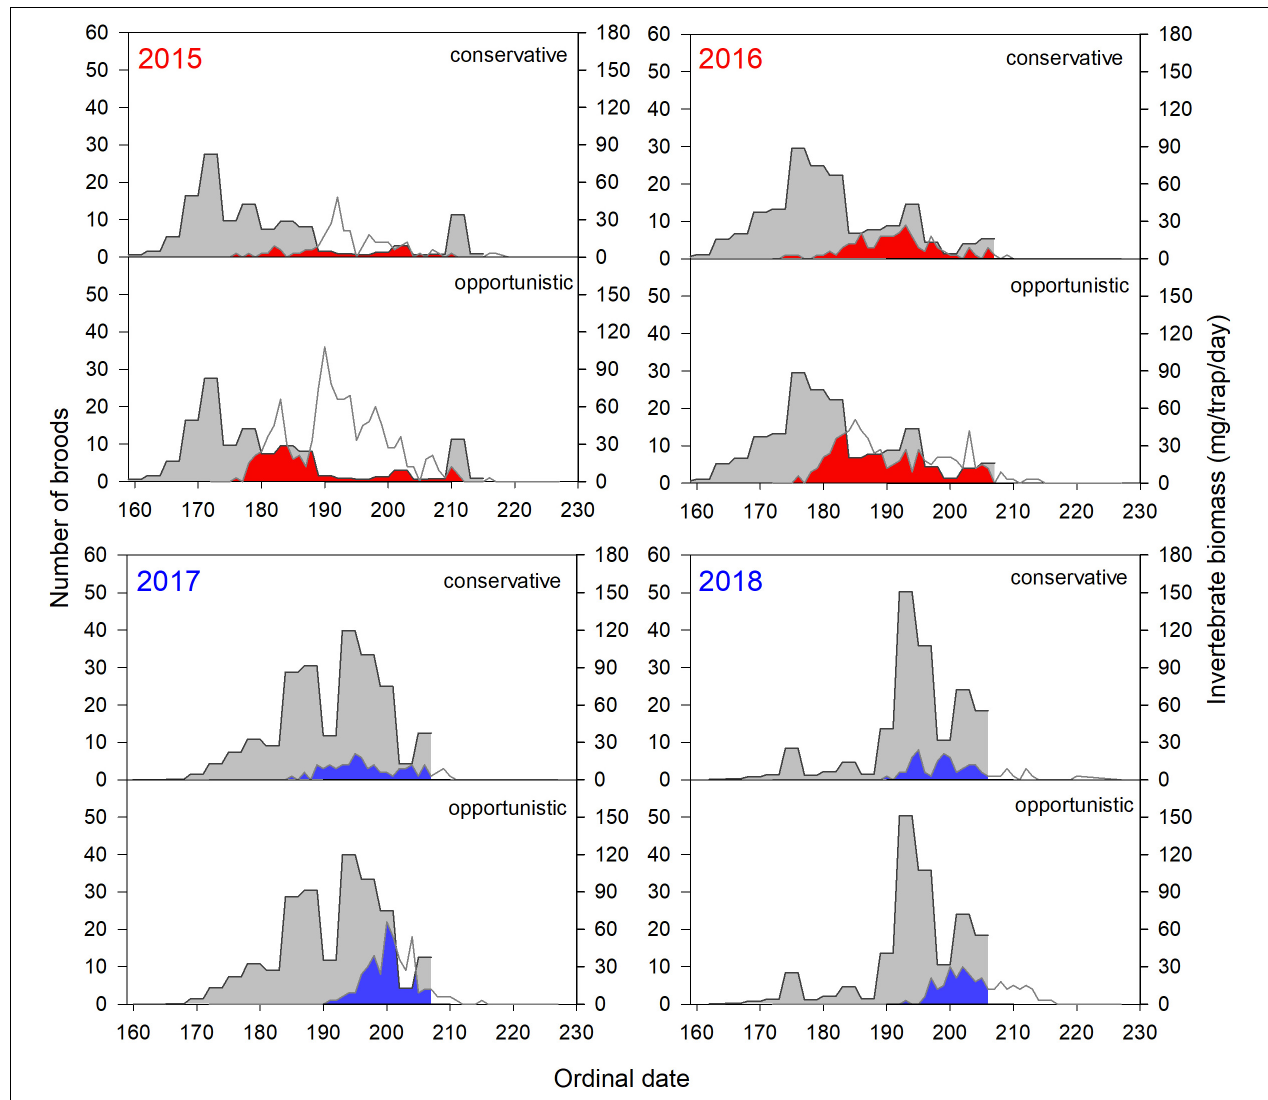
FIGURE 7 | Daily invertebrate biomass (gray) in relation to the number of conservative and opportunistic shorebird broods at peak energetic demand (i.e., 6 days post-hatch) in 2015–2018 at Utqia ˙ gvik. The area of overlap between the two curves (red in early springs 2015 and 2016; blue in late springs 2017 and 2018) illustrates the temporal degree of phenological match. The area outlined in white above red and blue areas reflects additional broods that were 6 days old. In most years, invertebrate sampling ended prior to the end of the brood rearing season (ordinal date 215, 207, 207, and 206 in 2015–2018, respectively); therefore, phenological match cannot be assessed for broods after these time periods. See Table 2 for species assignments to reproductive strategies and sample